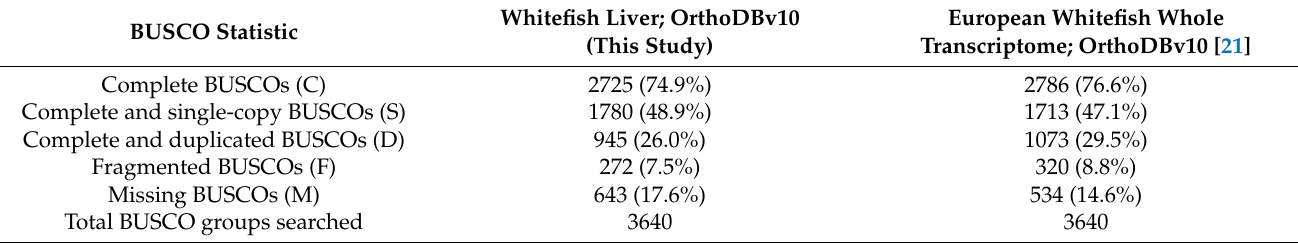
Table 1. Summary of the complete, duplicated, fragmented and missing orthologs inferred from the Benchmarking Universal Single-Copy Orthologs (BUSCO) search against the orthologs for Actinopterygii. Whitefish Liver; OrthoDBv10 European Whitefish Whole BUSCO Statistic (This Study) Transcriptome; OrthoDBv10 [21] Complete BUSCOs (C) 2725 (74.9%) 2786 (76.6%) Complete and single-copy BUSCOs (S) 1780 (48.9%) Complete and duplicated BUSCOs (D) Fragmented BUSCOs